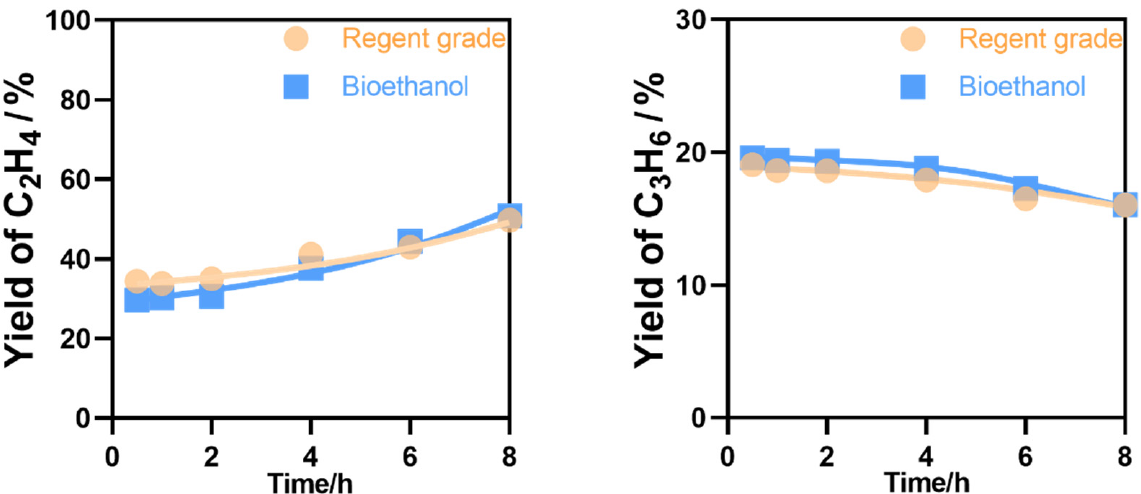
Figure 12. Ethylene and propylene yields of regent-grade ethanol and bioethanol catalytic conversions. Temperature, 400 °C; W/F = 0.0025 g/cm 3 ·min − 1 .